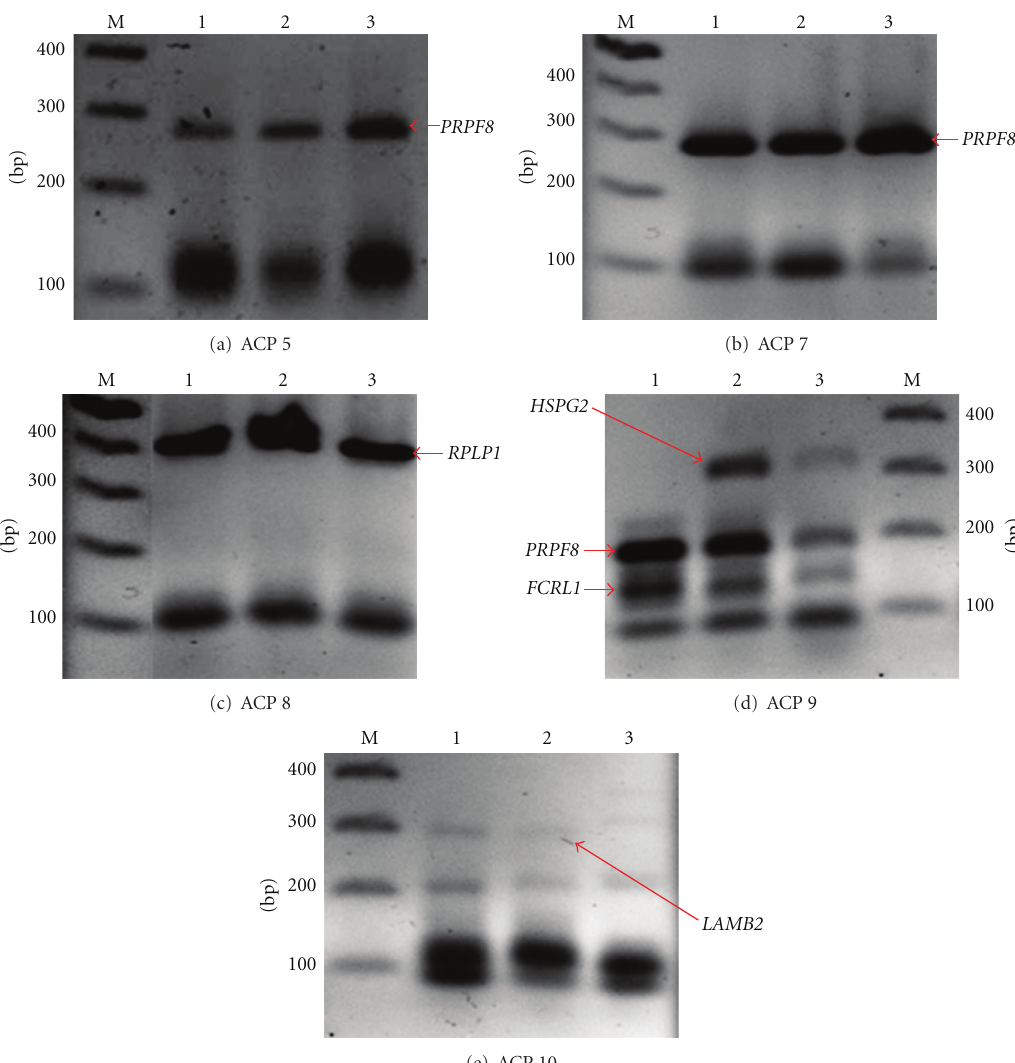
Figure 1: GeneFishing DEG screening results. There are 5 genes activated in pulp tissue (arrows). Lane 1: Normal; Lane 2: 14 days after force application; Lane 3: 28 days after force application; Lane M: 100 bp DNA